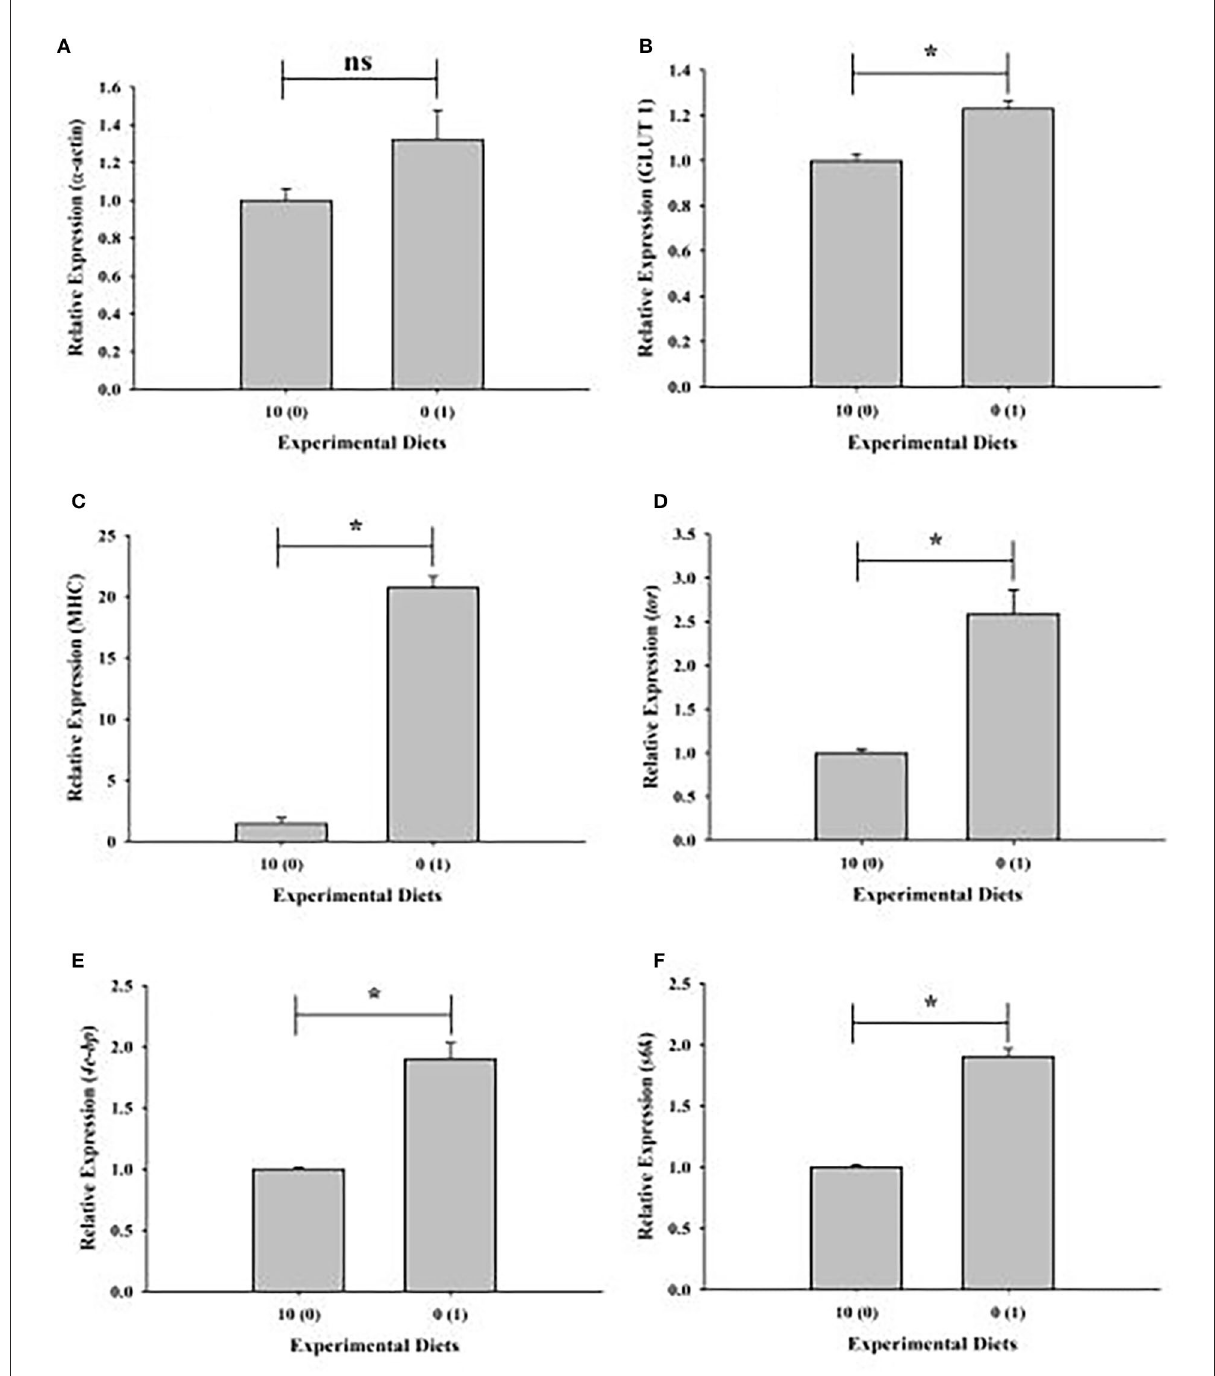
FIGURE4 Relative expression of muscle growth-related genes of shrimp fed with plant-based diets supplemented with squid by-product hydrolysate. (A) α -actin, (B) GLUT1, (C) MHC, (D) tor , (E) 4e-bp , (F) s6k . The asterisk indicates a significant difference between